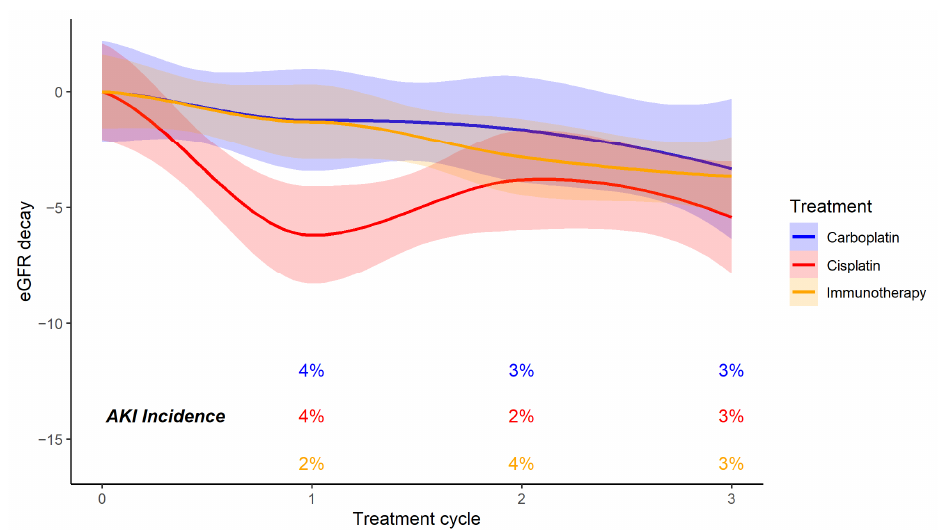
Figure 1. Mean eGFR decay and AKI incidence for each treatment cycle in the carboplatin, cisplatin, and ICI groups.